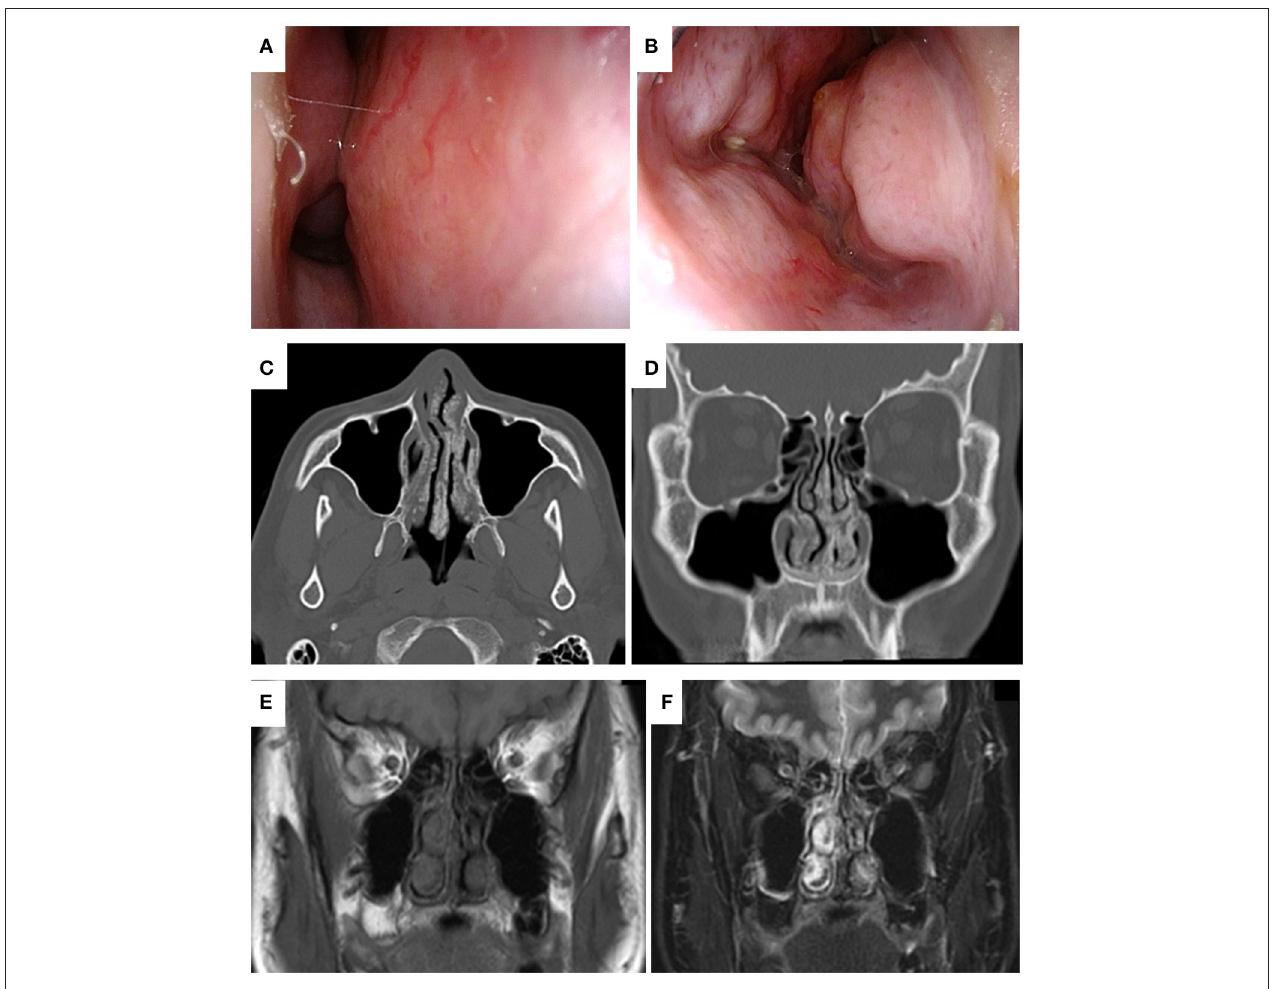
FIGURE 1 | Endoscopic findings of localized sinonasal amyloidosis viewed from the right (A) and left (B) nasal cavities at the first visit to our hospital. The deviation of nasal septum to the right. The mucosa was smooth and pink, with nodular thickening, and bilateral narrowing of the common nasal meatus was observed. Plain computed tomography (CT) of the present case obtained at the previous hospital. Axial (C) and coronal (D) views of bone window CT of the head showed the deviation of the nasal septum to the right, thickening of the bilateral nasal mucosa, and deposition of microcalcified material in the submucosa of the nasal cavity, including the bilateral nasal septum, and middle and inferior turbinates. Magnetic resonance images of the present case obtained at the first visit to our hospital. Coronal views of plain T1-weighted (E) and T2-weighted imaging (F) of the head showed bilateral thickening of the nasal mucosa and numerous hypointense punctate signal areas in the submucosa of the entire nasal